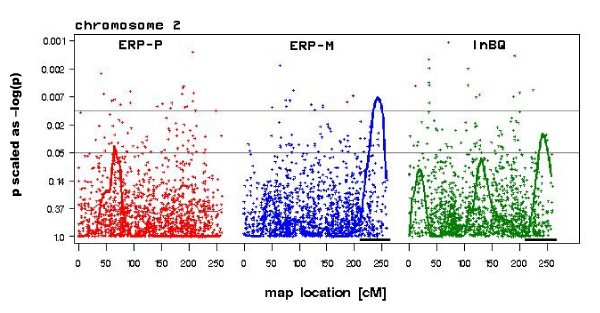
Comparison of nonparametric linkage and association test results for lnBQ, ERP-P and ERP-M on chromosome 2. LODs have been transformed to p-values by the relationship LOD = χ2df = 1/2ln(10) and plotted as a solid line. Dots represent family-based association test results.